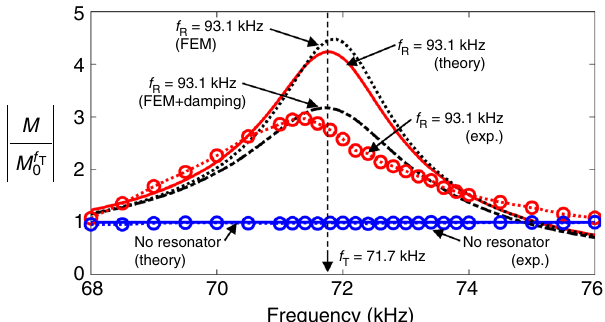
(cid:7) (cid:7) (cid:7) (cid:7) (cid:7) (cid:7) in a 0